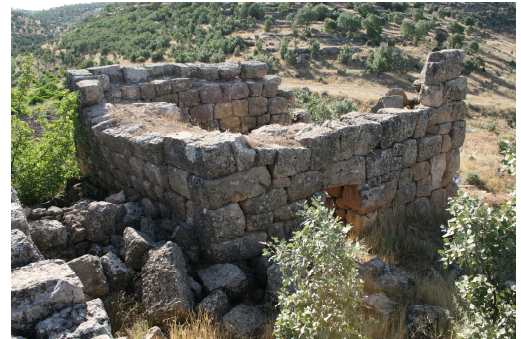
Fig. 6. Keferde. Panorama of the watchtower in the east of the settlement. View from the west. Photo: Kenneth Silver 2016. 2.5. The Lower Town of Keferde (Fig. 4.)